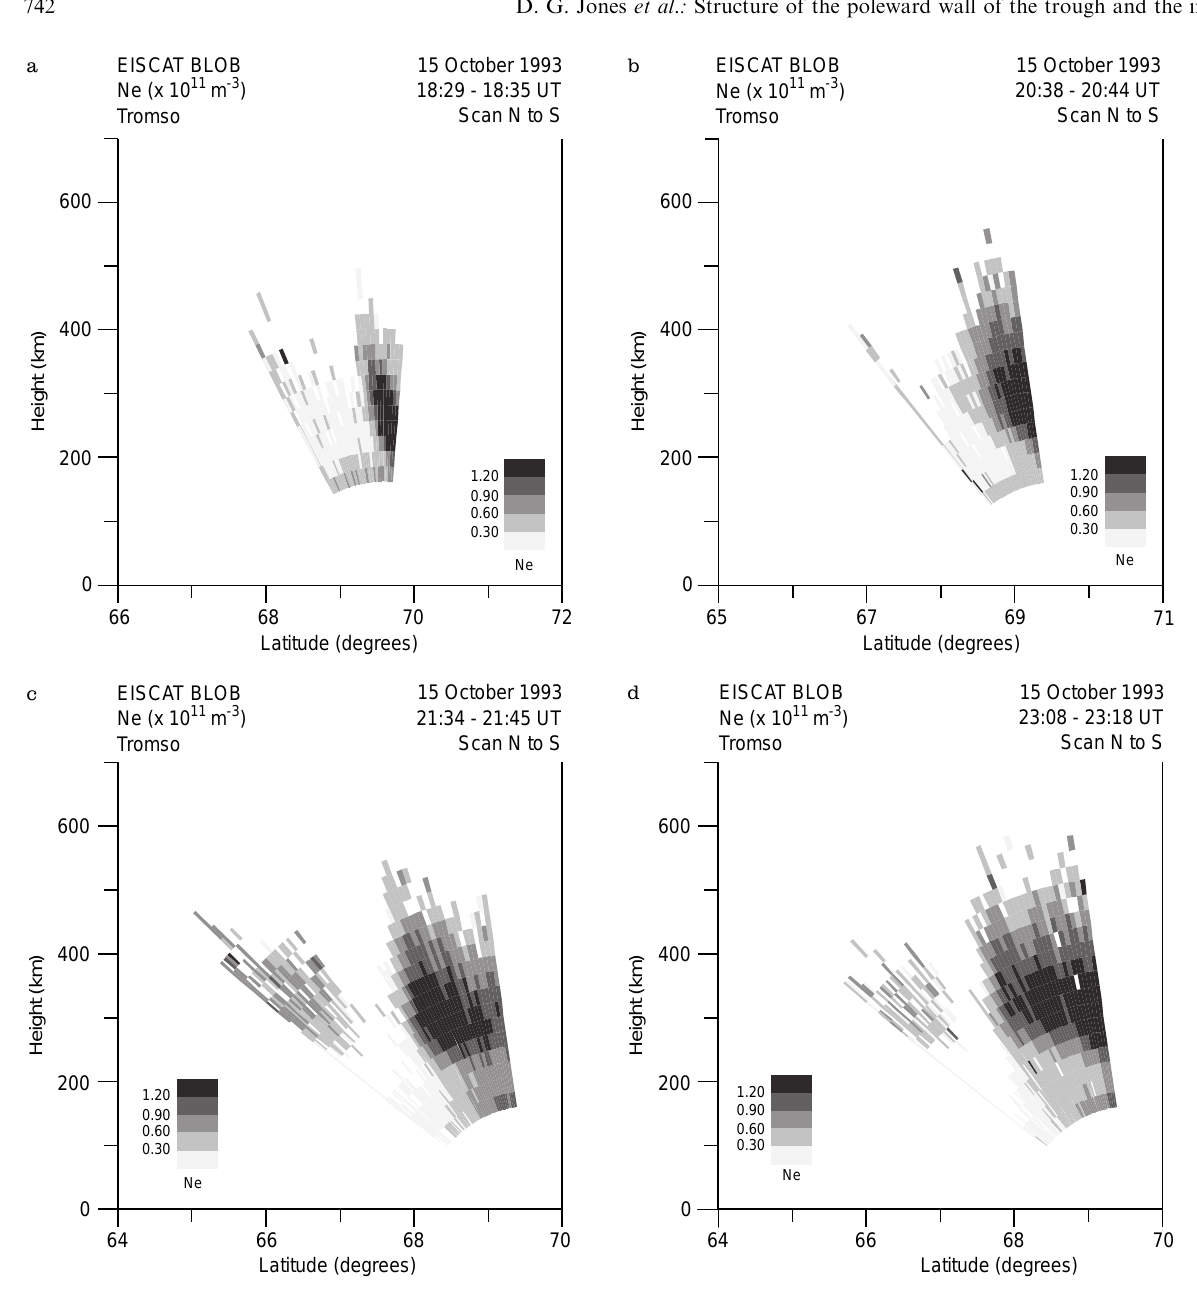
Fig. 2a–d. Electron densities from selected short scans of the EISCAT BLOB routine on the evening of 15